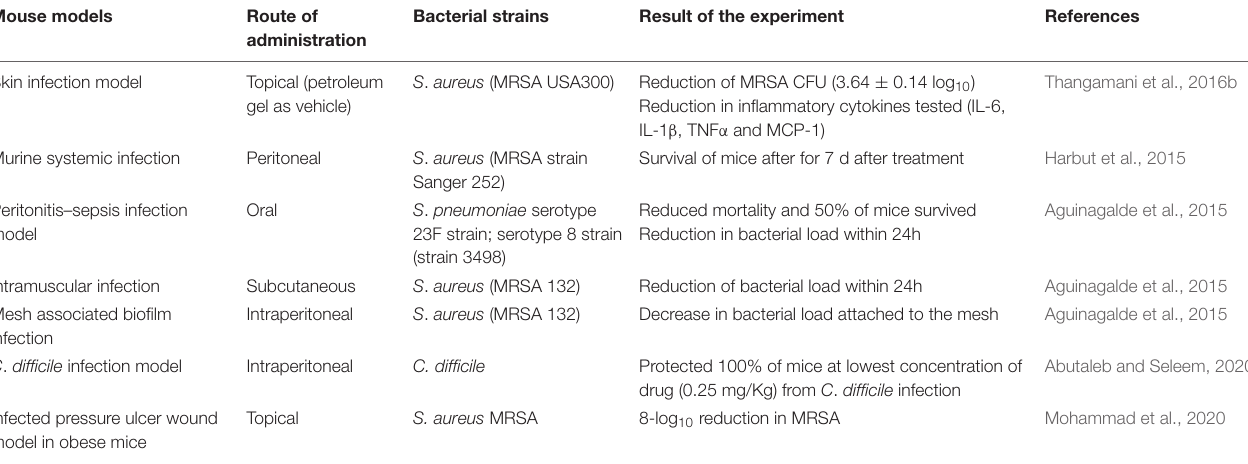
TABLE 2 | In vivo efficacy of auranofin in animal